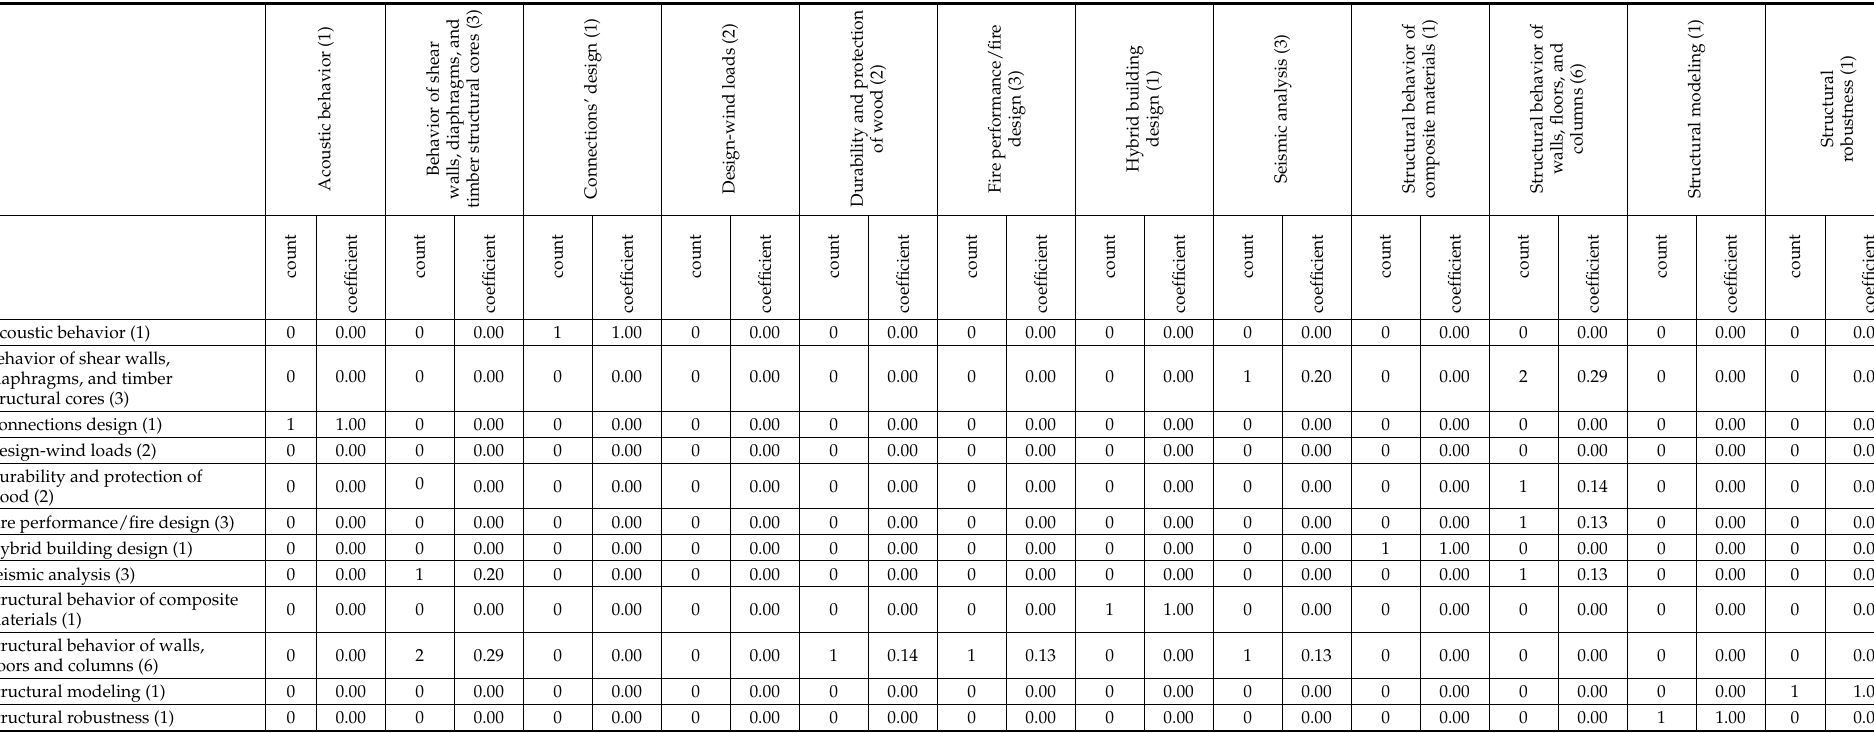
Table 5. Co-occurrences between the findings considered as limitations of the engineering and construction sciences category, from the review of scientific articles on timber